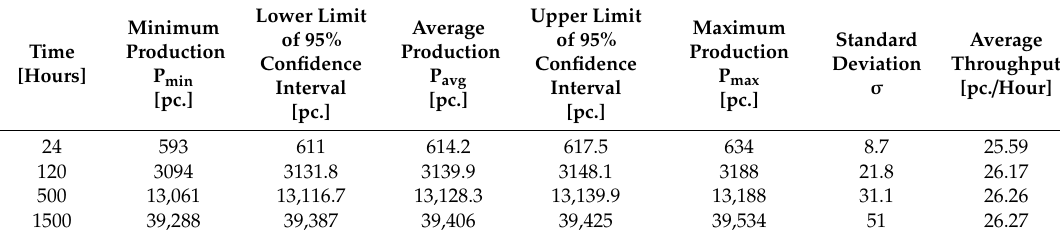
Table 2. The results of simulation experiments (Average production completed Pavg, in [pieces] for 6 AGVs with battery charging, without failures, 30 simulation runs in each experiment, 95% confidence level).